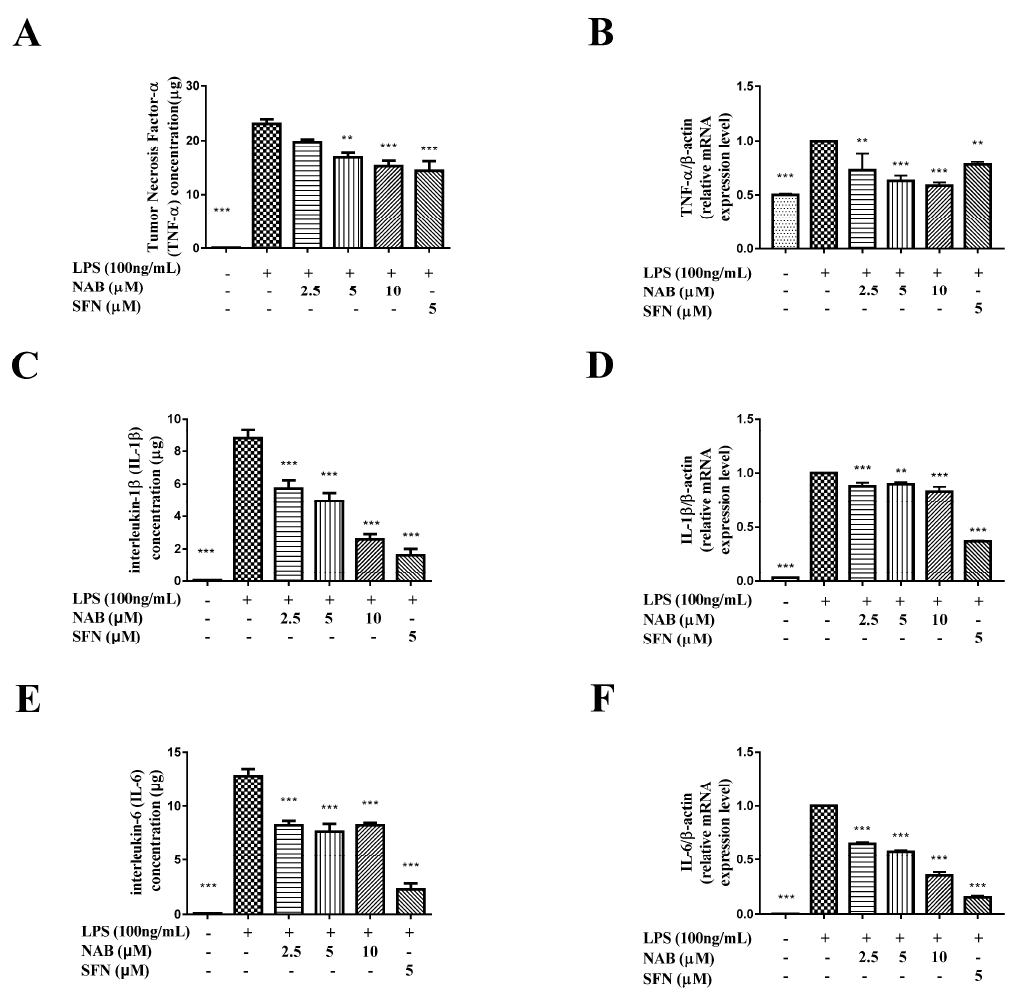
Figure 6. The effect of NAB on the production of TNF- α , IL-1 β , and IL-6 in LPS-activated RAW264.7 cells. Effects of NAB on the expression level of TNF- α ( A , B ), IL-1 β ( C , D ), and IL-6 ( E , F ) in LPS-stimulated RAW264.7 cells. Cells were pretreated with NAB or positive control drug (sulforaphane, SFN) for 1 h and then stimulated with LPS (100 ng/mL) for 18 h. Total mRNA was prepared, and the mRNA expression of TNF- α , IL-1 β , and IL-6 was detected. Culture medium was collected, and ELISA was used to measure the expression level of TNF- α , IL-1 β , and IL-6. In the qRT-PCR analysis, the density ratio of the LPS group (model control) was set to 1. In the ELISA analysis, the variances were compared with the LPS group. Results are expressed as mean ± SEM of three independent experiments. ** P < 0.01 and *** P < 0.001 vs. LPS-stimulated cells.